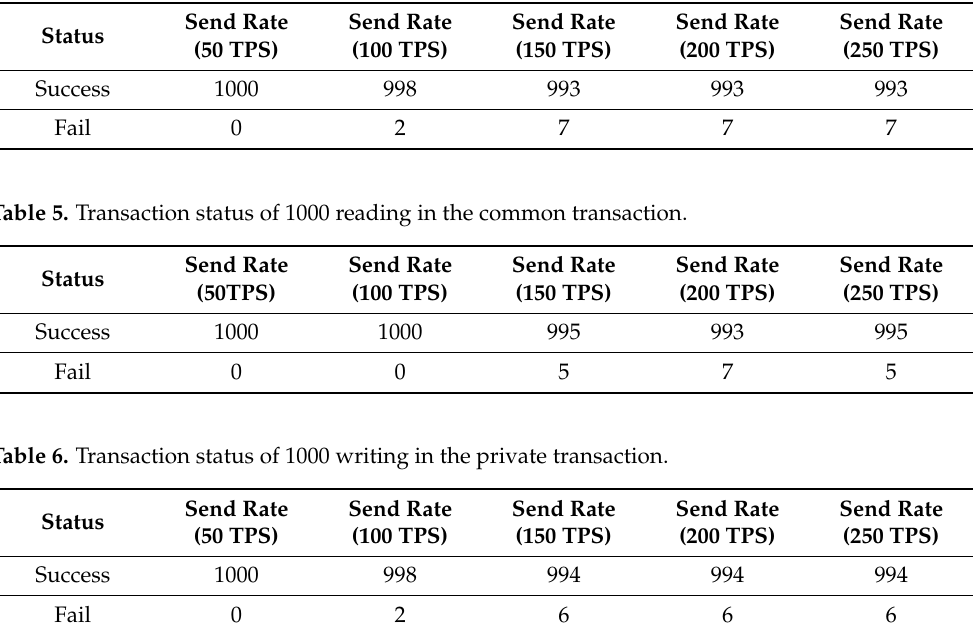
Table 4. Transaction status of 1000 writing in the common transaction.